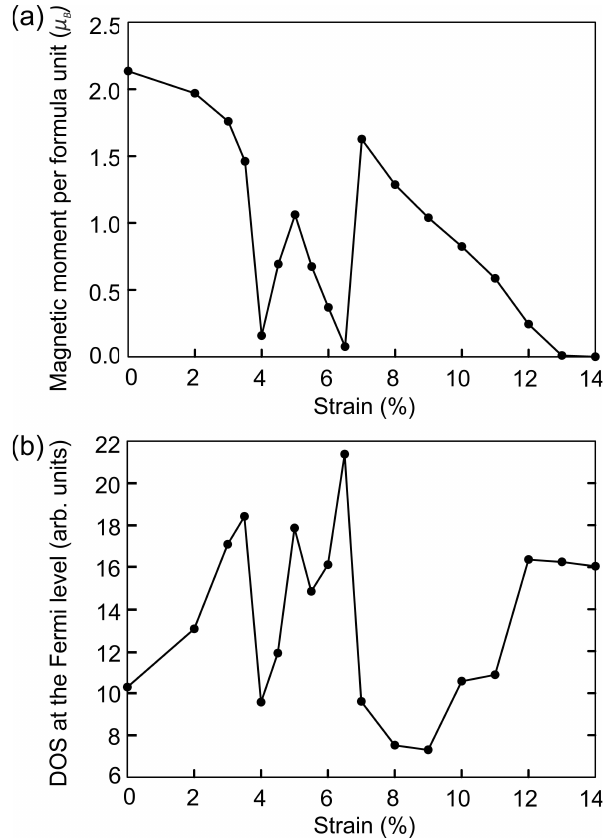
Figure 4. The dependence of the total magnetic moment ( a ) and DOS at the Fermi level ( b ) on isotropic